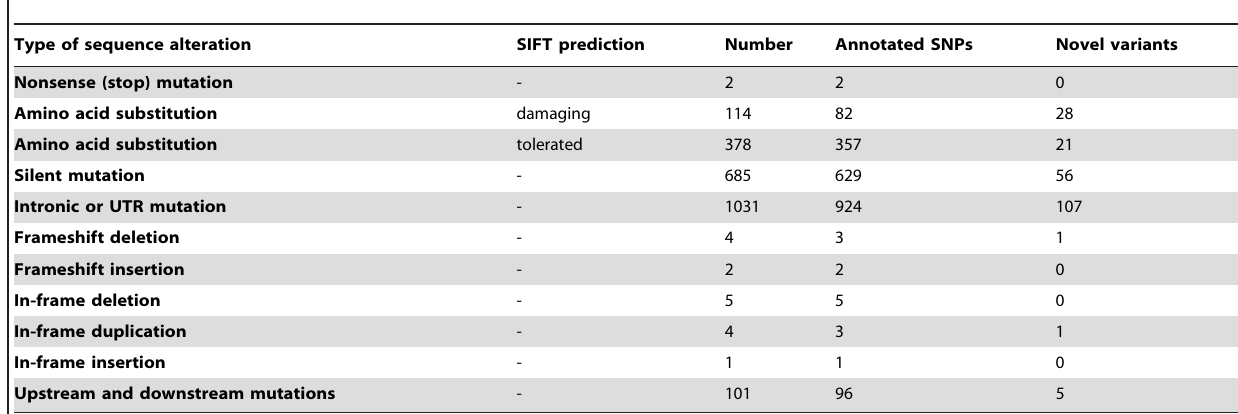
Table 1. Classification of the type of homozygous variants obtained by linkage analysis and whole exome sequencing.